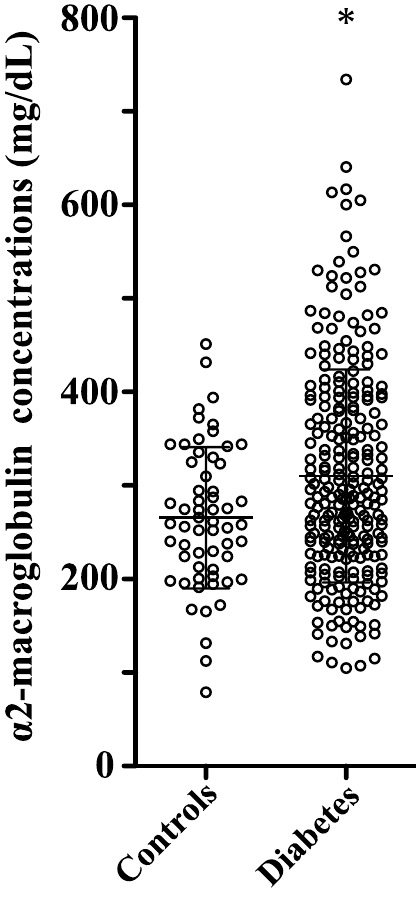
Figure 3. Comparison of serum α 2 -macroglobulin levels in healthy volunteers and in patients with diabetes mellitus. Serum samples obtained from 59 healthy volunteers (Controls) and 248 patients with diabetes were subjected to ELISA of α 2 -macroglobulin. Wide horizontal bars indicate the mean and the shorter horizontal bars indicate the SD. The unpaired t -test was used to compare serum levels for the two groups. * p < 0.05 vs . controls.